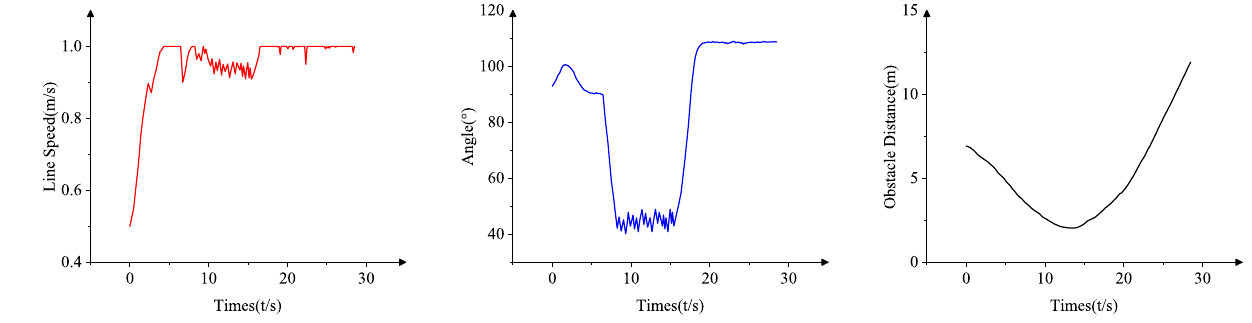
Figure 23. Parameters of the FUZZY-CCDWA algorithm for head-on situation.